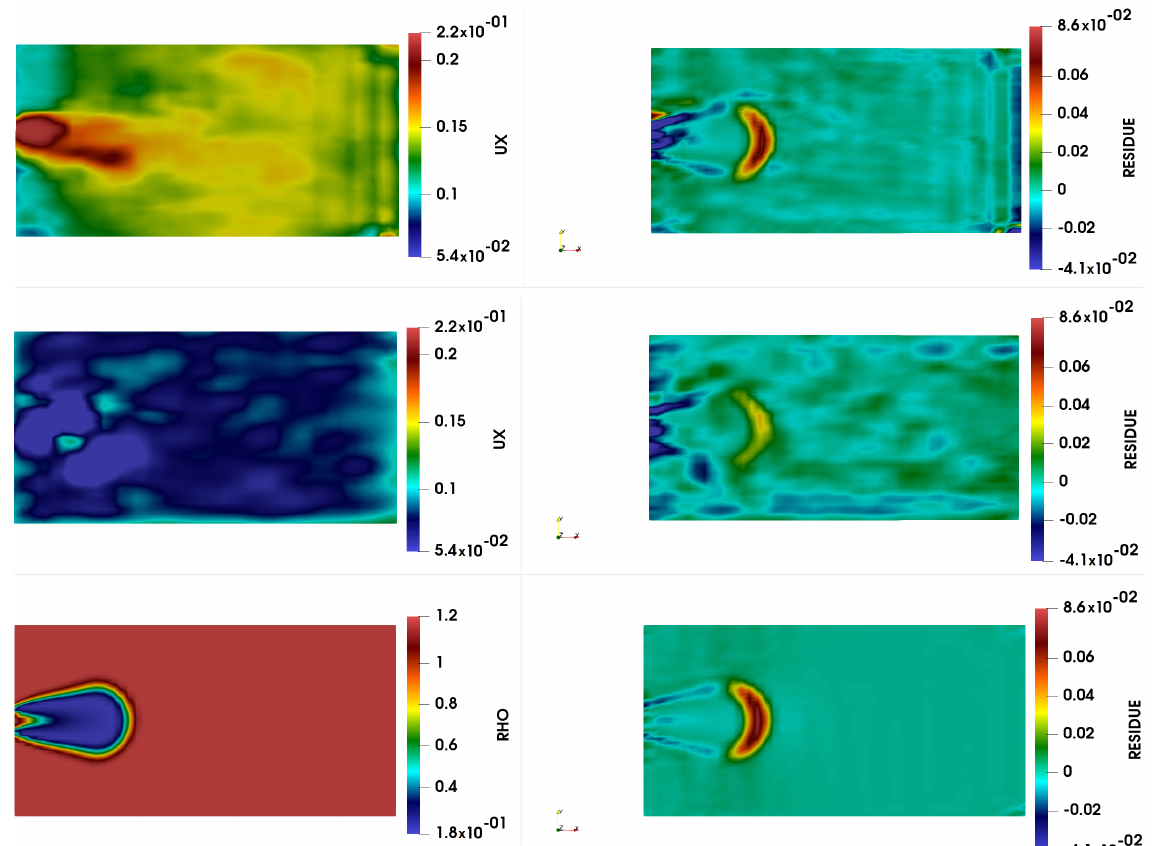
Figure 22. On the top left, the 805-th decoder generation µ h ( t ) ∼ p θ ( µ h ( t ) | z ) from a sample of the probability distribution p θ ( z ) for the data-targeted VAE. On the top right, the residue of this generated sample, ∂ρ h ( t 805 ) middle left, the 805-th decoder generation µ h ( t ) ∼ p θ ( µ h ( t ) | z ) from a sample of the probability distribution N ( 0,1 ) for the classical VAE. On the middle right, the residue of this generated sample, ∂ρ h left, the high-fidelity density field ρ h ( t 805 ) projected on the Cartesian mesh. On the bottom right, the accurate residue ∂ρ h ( t 805 ) + div ( ρ ( t ) u ( t )) 805 805 h h ∂ t